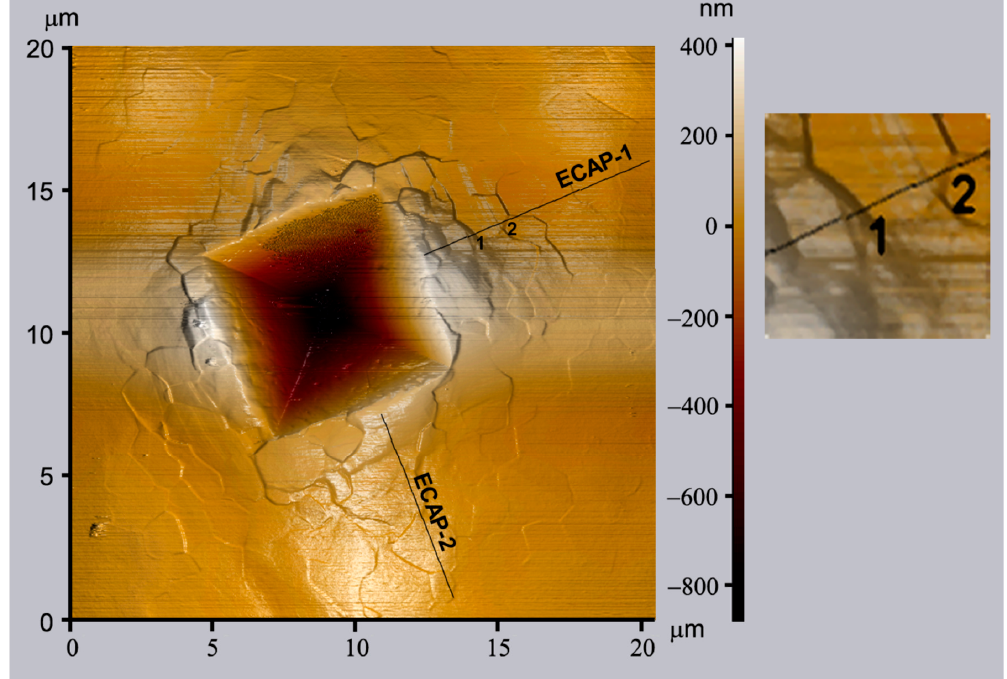
Figure 9. An atomic force microscopy (AFM) micrograph of the surface of an UFG pure Al sample deformed by indentation using a Vickers indenter. Reproduced with permission [67]. Copyright 2006, Elsevier.